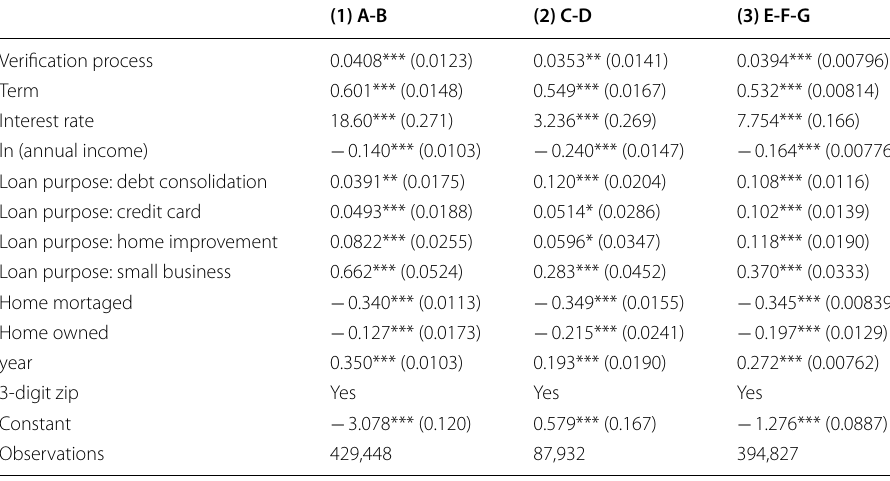
Table 13 Endogeneity check: regressions for the three risk